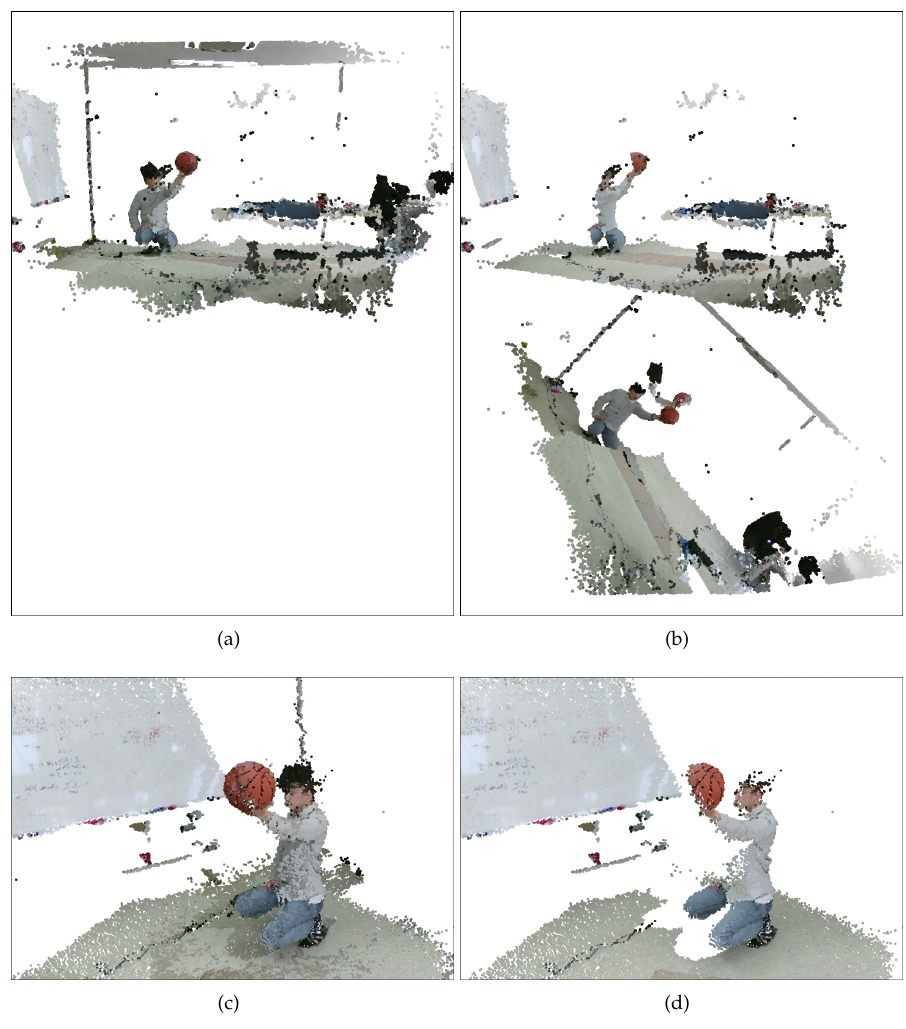
Figure 21. Rendering results (static basketball set). ( a , c ) Proposed method (BA). ( b , d ) Su et al. [20]. Refer to the text for more detail. Best viewed in color.